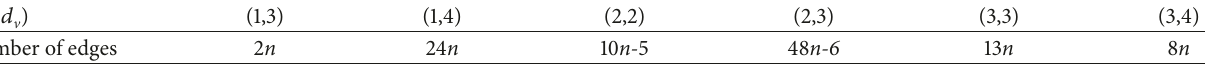
Table 1: Edge partition of Porphyrin dendrimers based on degree of end vertices of each edge.